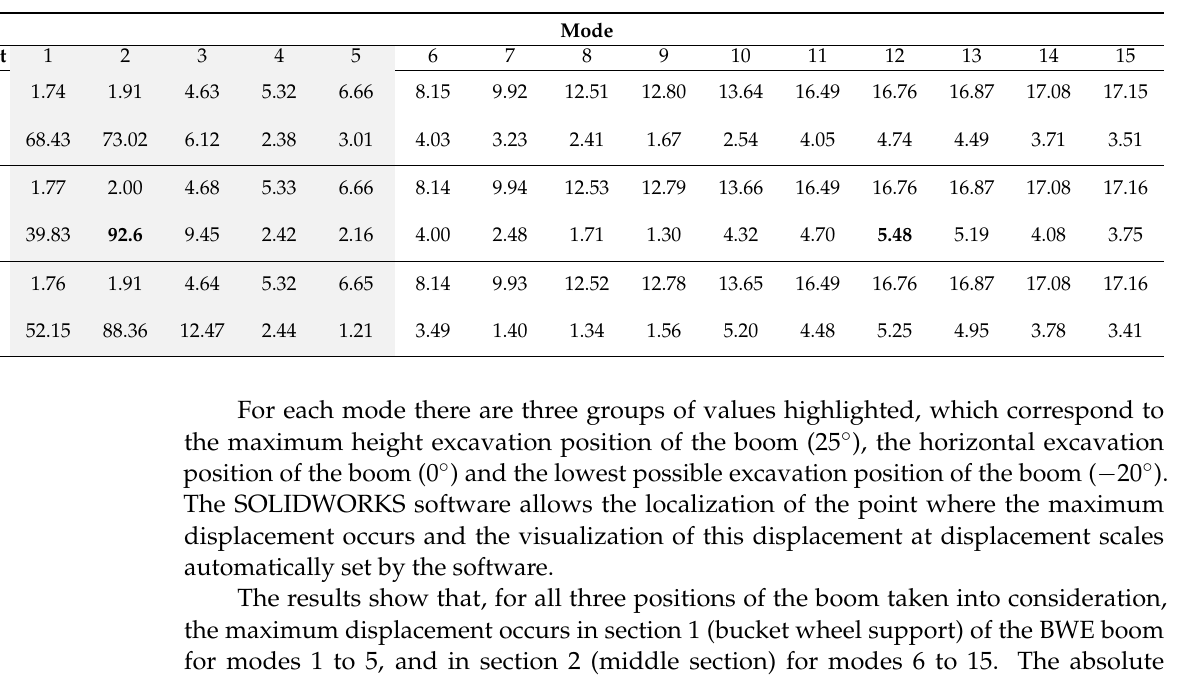
Table 2. Results of the simulation: Values of the maximum displacements and their corresponding